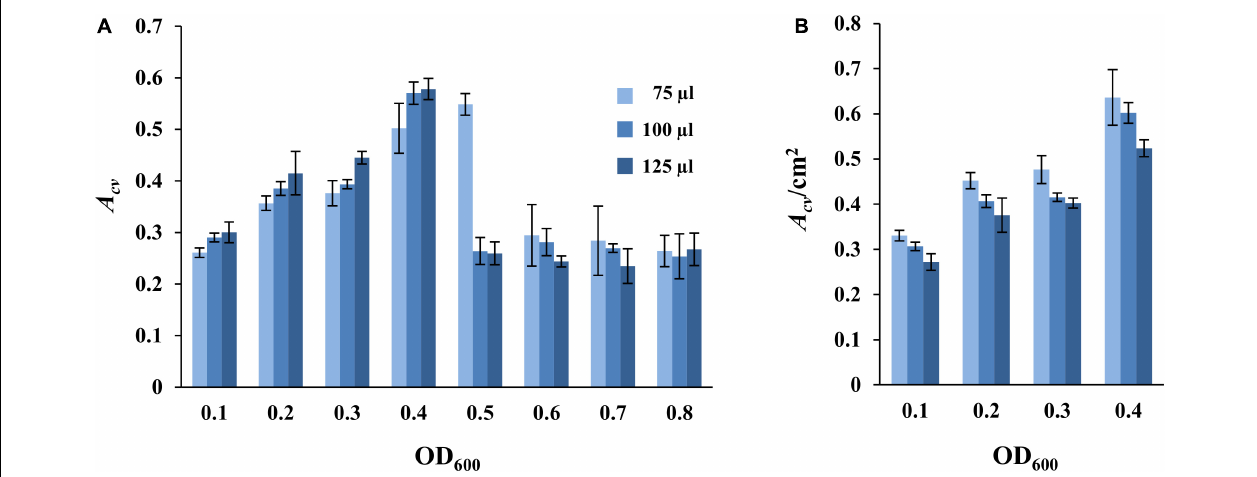
FIGURE 2 | Impact of culture volume and cell density on static SBF formation. Different volumes of DK1622 (WT) cells at starting OD 600 as indicated were inoculated into microwells for biofilm development at 32 ◦ C under static conditions. The amount of SBF per microwell was represented either by A cv (A) or by A cv /cm 2 (B) which is normalized to the submerged surface area as described in section “Materials and Methods.” Samples with starting OD 600 of 0.5 or higher are not included in panel (B) due to the formation of PBFs (see text and Supplementary Figure 2 for more